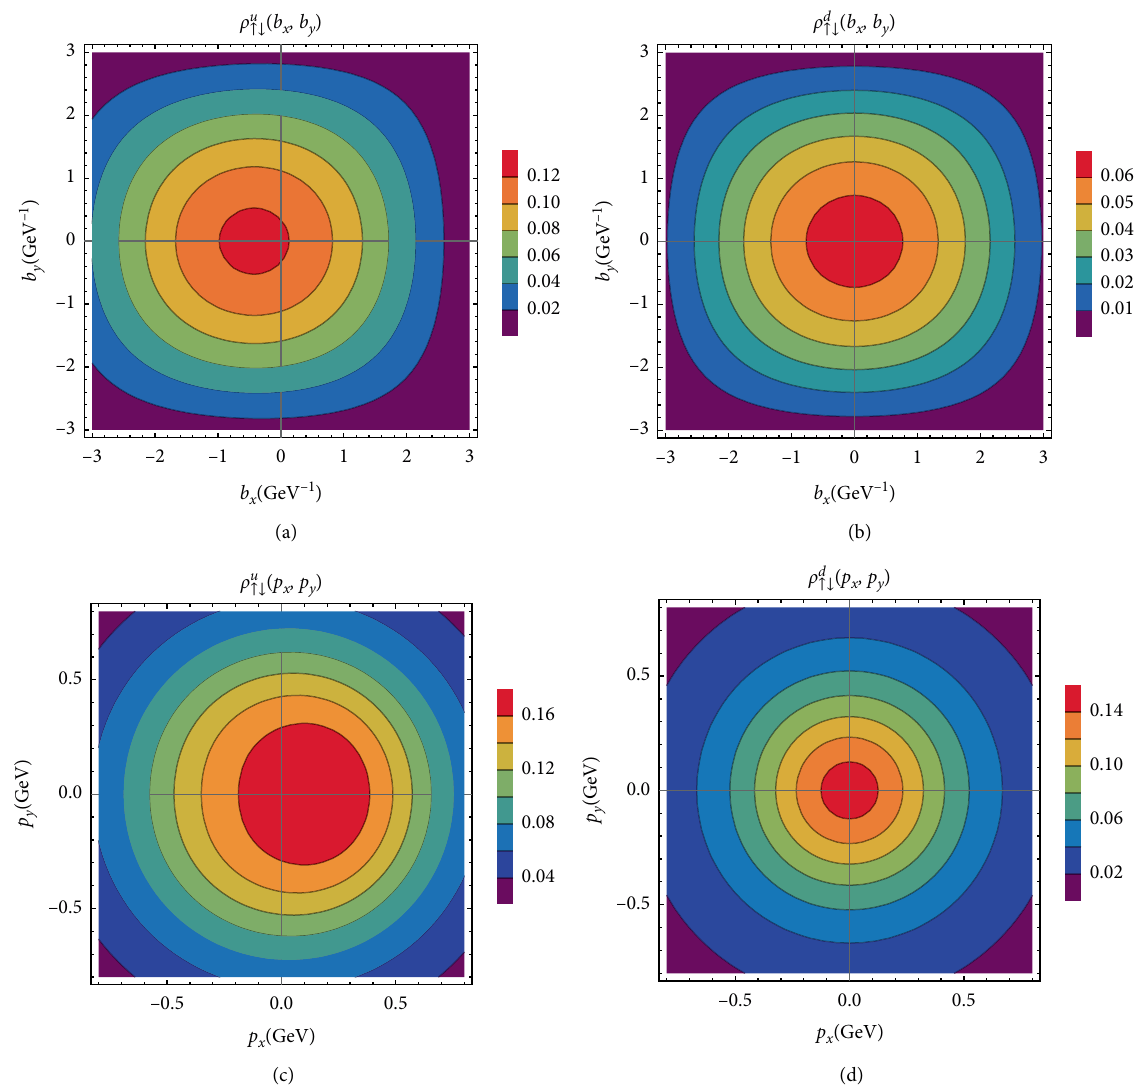
Figure 2: The plot of Wigner distribution 휌 (left panel) and 𝑑 -quark (right panel).